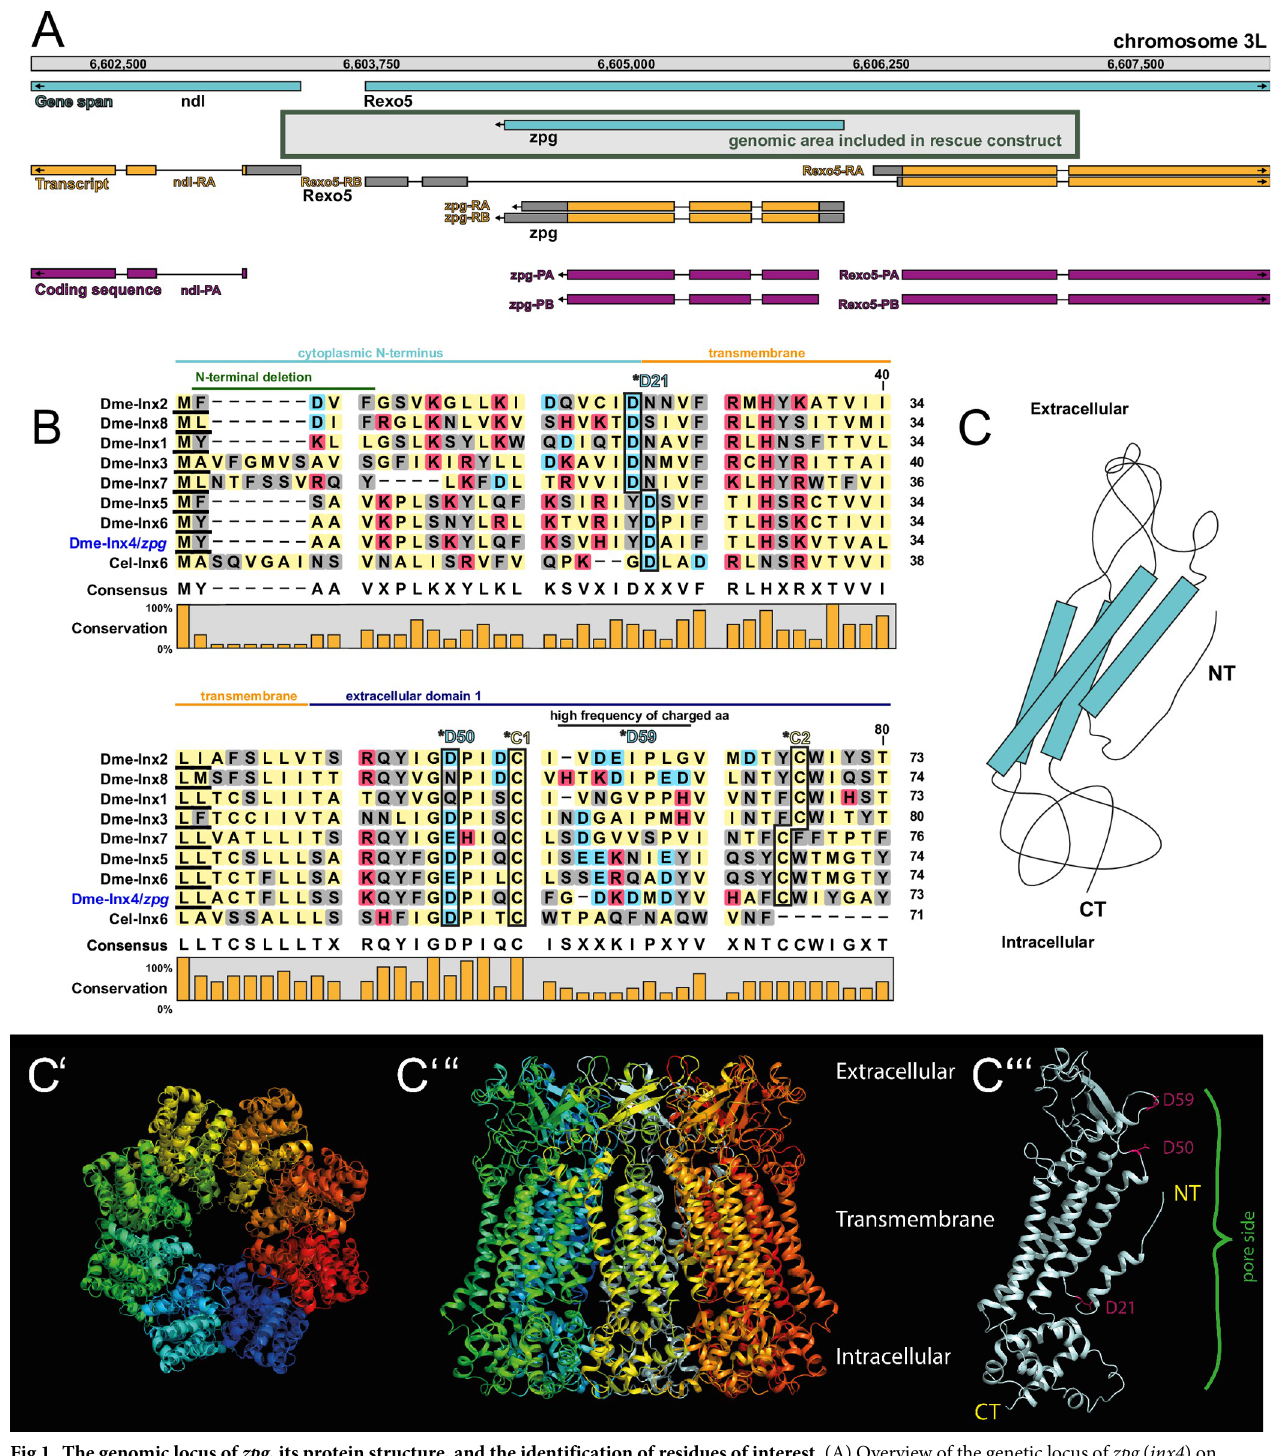
Fig 1. The genomic locus of zpg , its protein structure, and the identification of residues of interest. (A) Overview of the genetic locus of zpg ( inx4 ) on chromosome 3L, showing genes (blue), transcripts (orange) and coding sequence (magenta) of Zpg and the neighboring genes. The DNA stretch that is included in the rescue construct used in this study is indicated by a grey box. (B) Sequence alignment of Zpg (Inx4) with other Drosophila innexins and C . elegans INX-6, which was used as basis for in silico 3D structure homology modeling. The N-terminal portions of the proteins are depicted (approximately amino acid 1–80, see numbers on the right) and the degree of conservation is indicated in bar graphs. Polar amino acids are shown in grey, hydrophobic in yellow, positively charged in magenta and negatively charged in cyan. The residues D21, D50 and D59 and well as the first (C1) and second cysteine (C2) in